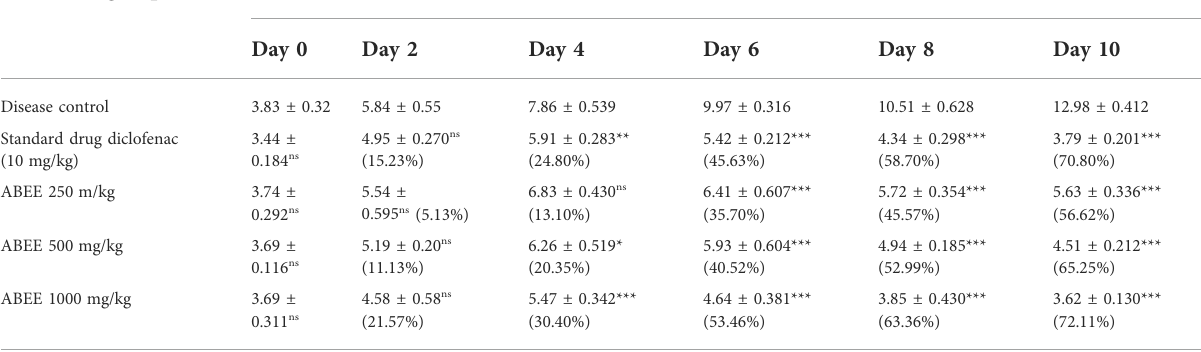
TABLE 6 Effects of ABEE on paw diameter of formaldehyde-induced arthritic